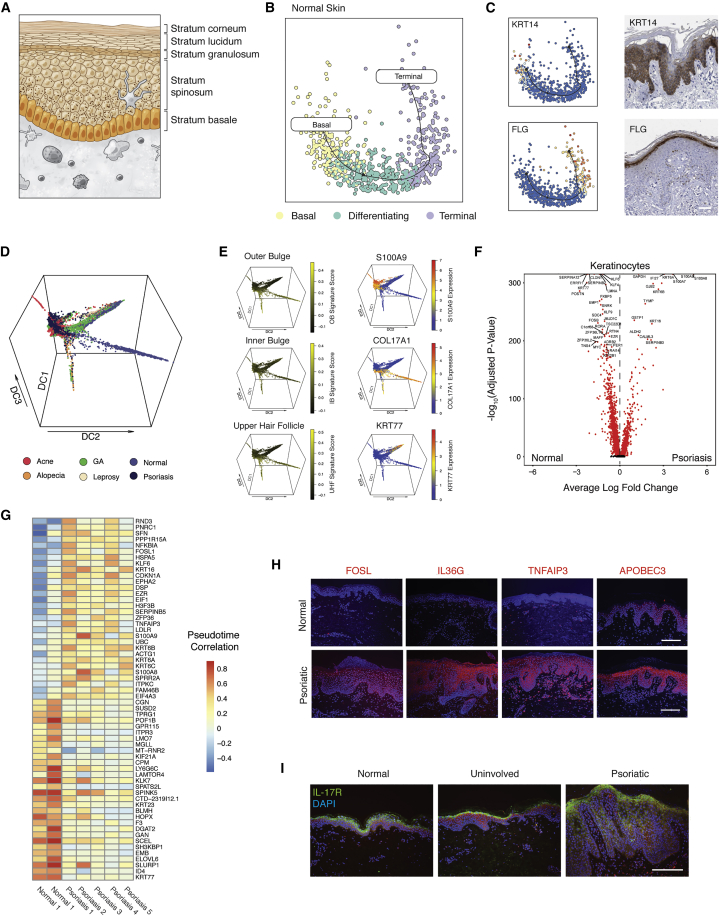
Keratinocyte Differentiation Trajectories(A) Diagram showing the layers of the epidermis and morphologic changes associated with keratinocyte differentiation.(B) t-SNE plot showing differentiation trajectory of keratinocytes from normal skin from basal cells (yellow) through differentiating cells (aqua) and terminal keratinocytes (purple).(C) (Top, left) t-SNE plot of normal keratinocytes colored by KRT14 expression. Shown at the top right is KRT14 staining from the human protein atlas (Uhlén et al., 2015). Shown on the bottom left is a t-SNE plot of normal keratinocytes colored by FLG expression. Shown on the bottom right is FLG staining from the human protein atlas (Uhlén et al., 2015). Scale bars, 50 μm.(D) Diffusion map of 10,777 keratinocytes colored by inflammatory skin condition. Axes correspond to diffusion components 1, 2, and 3.(E) Diffusion map of keratinocytes colored by signatures of hair-follicle-specific gene expression (Joost et al., 2016) (Left: outer bulge, inner bulge, and upper hair follicle) and genes that distinguish basal (COL17A1), normal (KRT77), and inflamed (S100A9) keratinocytes.(F) Volcano plot of genes differentially expressed between psoriatic and normal keratinocytes. Log10-fold change values are shown on the x axis and −log10 adjusted p values are shown on the y axis.(G) Heatmap showing gene-specific Pearson correlation values between diffusion pseudotime and gene expression for two normal skin biopsies and five psoriatic biopsies.(H) (Top) Immunofluorescence staining in normal (above) and psoriatic (below) for FOSL, IL36G, TNFAIP3, and APOBEC3. All images stained for nuclei (DAPI) and gene of interest (red fluorescence). Scale bar, 100 μm.(I). Immunofluorescence staining for IL-17R expression (green) in normal (left), uninvolved (middle), and psoriatic skin (right). Scale bar, 100 μm.